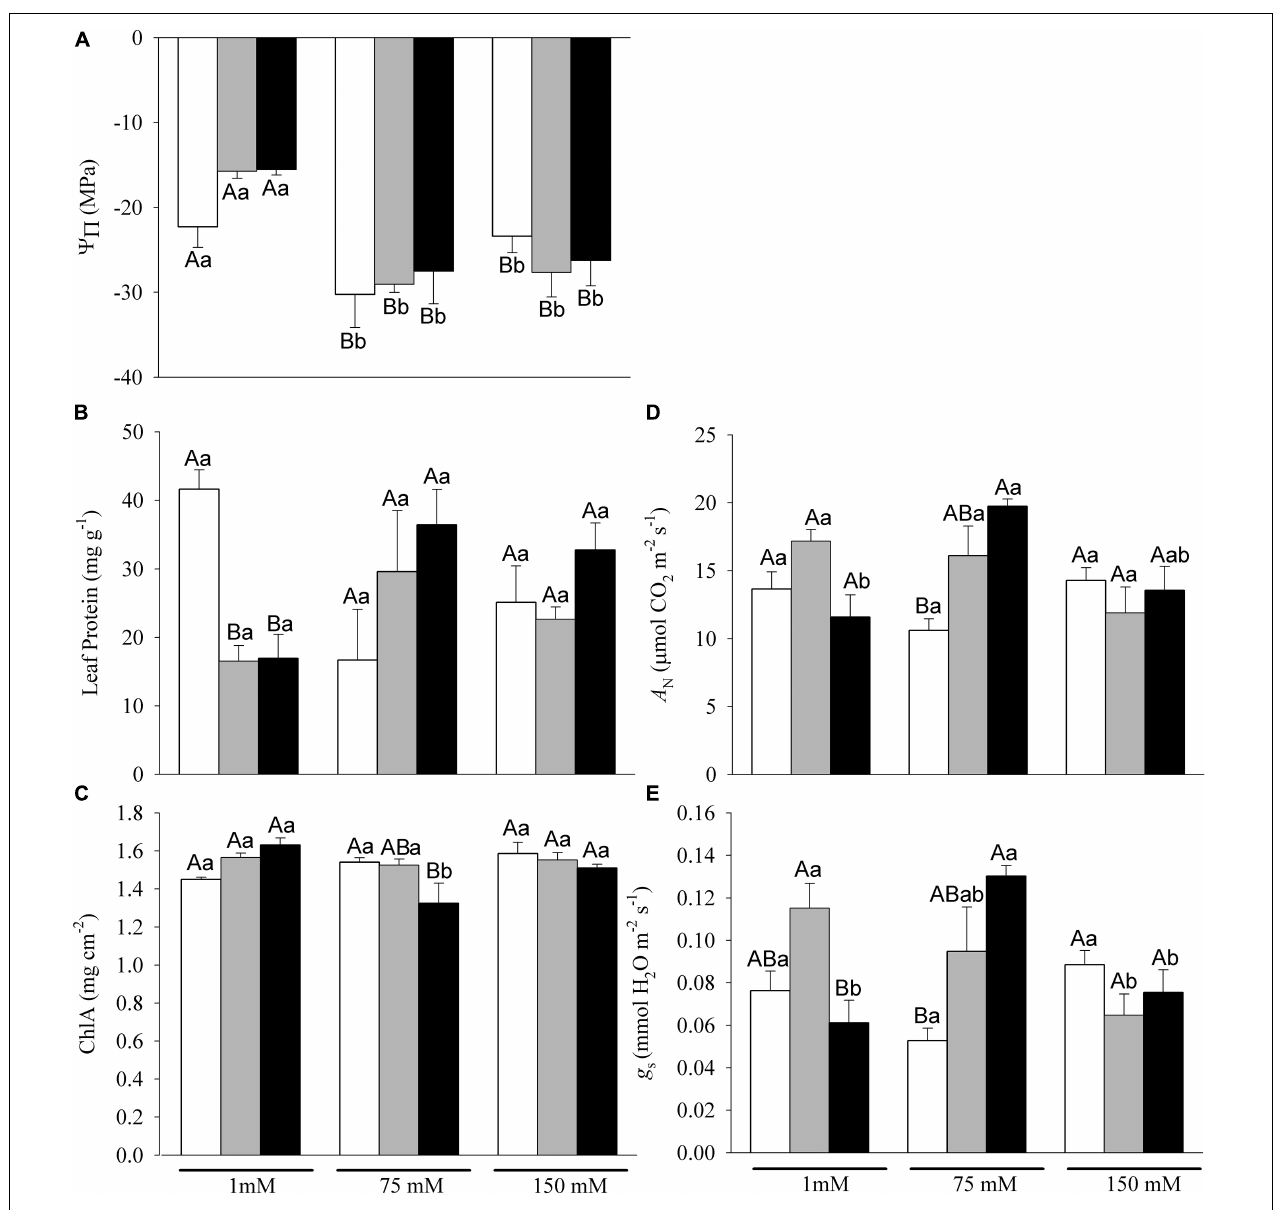
FIGURE 3 | Leaf physiological traits: (A) Osmotic potential ( (cid:57) π ), (B) Leaf protein, (C) Chlorophyll a concentration (Chl a), (D) Net Photosynthesis rate ( A N ), (E) Stomatal conductace ( g s ) of C, P and AM plants (white, gray and black bars, respectively) at 1, 75 and 150 mM NaCl. Values are mean and SE of six replicates. Different capital letters indicate significant differences among nutritional levels (C, P and AM) within the same salt level, and lowercase letters indicate significant differences among salt levels within the same nutritional level, from post hoc Tukey